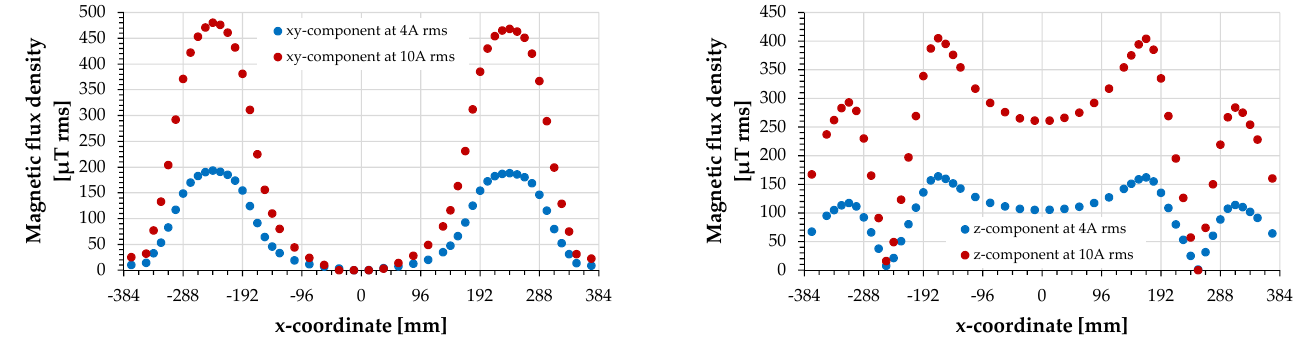
Figure 2. Magnetic flux density of the magnetic field of the ground assembly along the x -axis of the coordinate system at y = 0mm and currents of 4Arms and 10Arms ( left ) Component in the xy -plane ( right ) z -component.